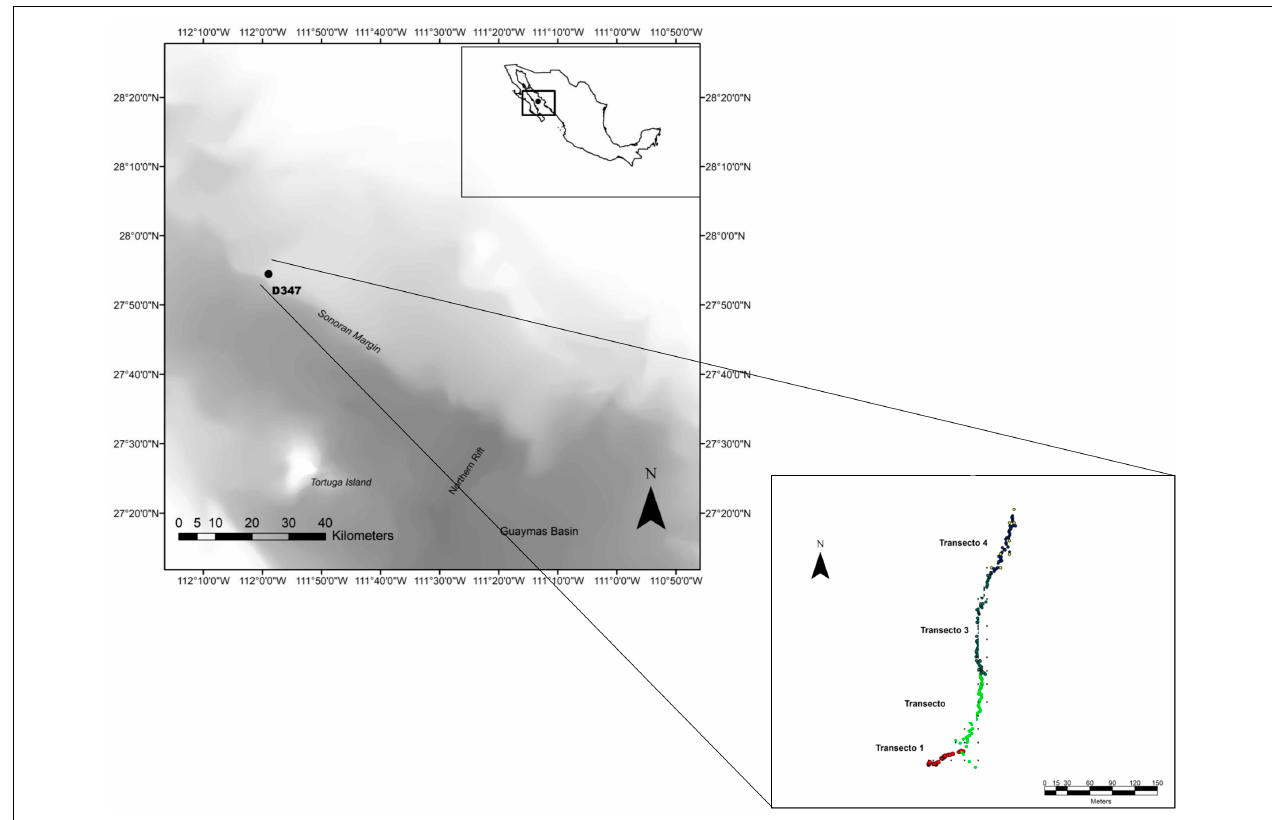
FIGURE 1 | Location of dive D347 in the NW limit of Guaymas Basin and Sonoran Margin in the Gulf of California where four video sections for megabenthic epifauna prospection were performed at a depth range of 849–990